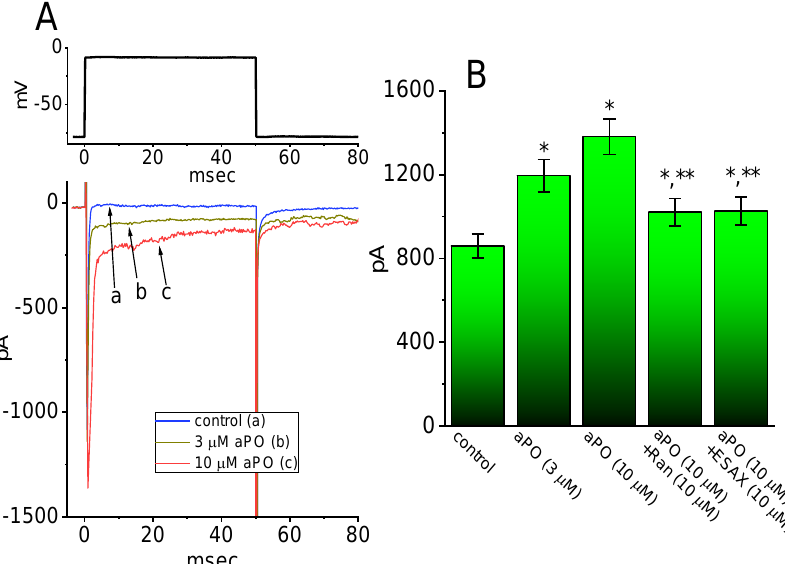
Figure 8. Effect of aPO on depolarization-activated I Na present in HL-1 cardiomyocytes. In this set of experiments, we kept cells immersed in Ca 2+ -free Tyrode’s solution and the electrode was filled with Cs + -enriched solution. When whole-cell configuration was established, we voltage-clamped the cell at −80 mV and the brief depolarization to −10 mV was delivered to it. ( A ) Representative I Na traces activated by depolarizing command pulse (indicated in the upper part). a: control; b: 3 μM aPO ; c: 10 μM aPO . ( B ) Summary bar graph showing effects of aPO , aPO plus ranolazine (Ran), and aPO plus esaxerenone (ESAX) on peak amplitude of I Na in HL-1 heart cells (mean ± SEM; n = 8 for each bar). Current amplitude was measured at the beginning of 50-ms depolarizing pulses from −80 to −10 mV. Data analyses were performed by ANOVA-1 ( p < 0.05). * Significantly different from control ( p < 0.05) and ** Significantly different aPO (10 μM) alone group ( p < 0.05).